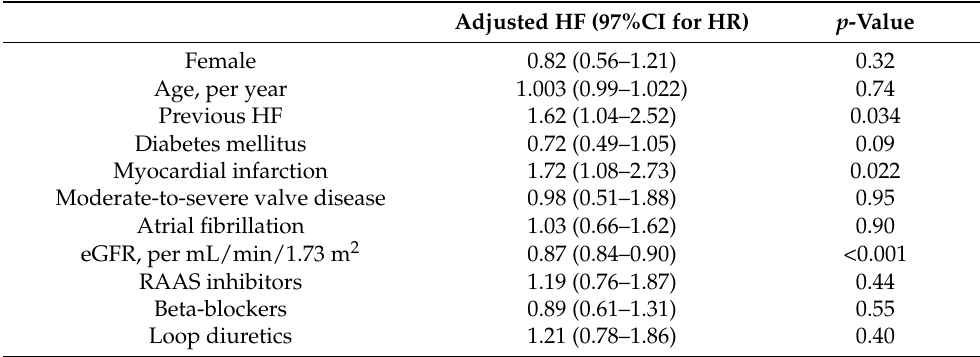
Figure 1. Kaplan–Meier curves for long-term outcome divided by a history of HF. ( Panel A ): All-cause Figure 1. Kaplan – Meier curves for long - term outcome divided by a history of HF. ( Panel A ) : All - death or renal replacement therapies. ( Panel B ): All-cause mortality. cause death or renal replacement therapies. ( Panel B ) : All - cause mortality. Table 3. Multivariate Cox proportional model for the hazard ratio of 2-year all-cause mortality or Table 3. Multivariate Cox proportional model for the hazard ratio of 2 - year all - cause mortality or need for renal replacement need for renal replacement therapies.